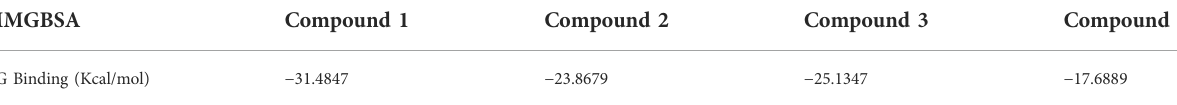
TABLE 6 Free energy of Binding result of the selected